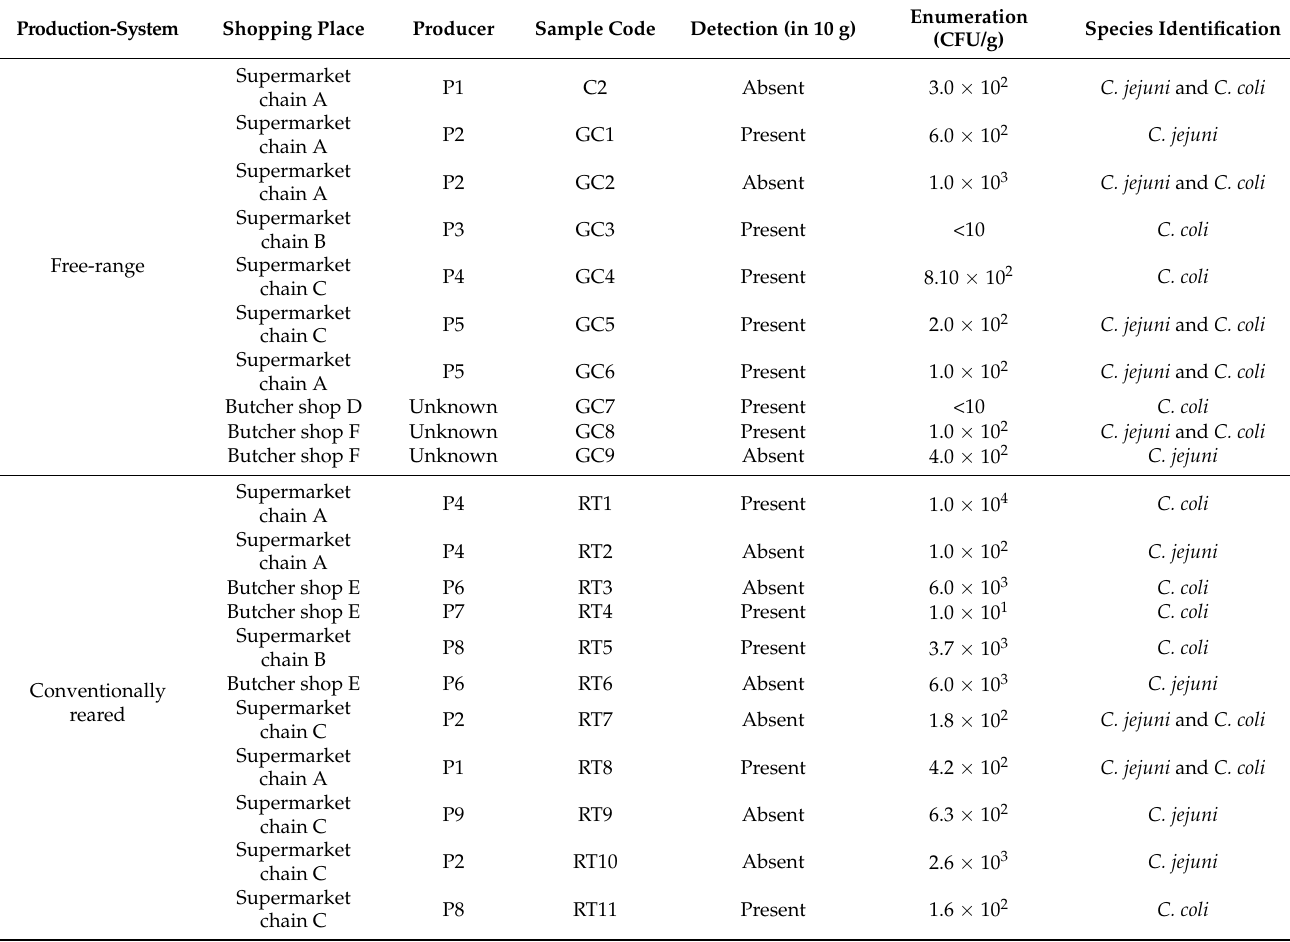
Table 1. Occurrence of Campylobacter spp. and levels of contamination of samples from conventionally reared and free-range production